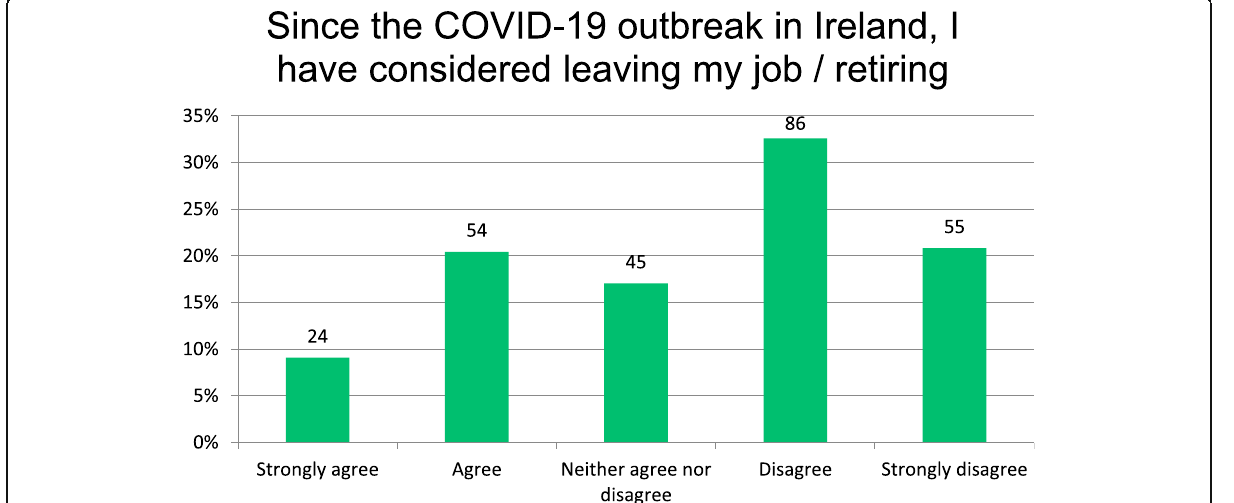
Fig. 4 Since the COVID-19 outbreak in Ireland, I have considered leaving my